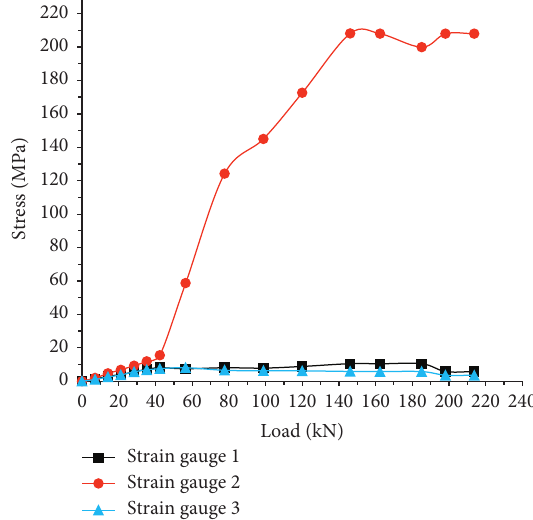
Figure 16: LPCSHTHSC SL-3 stress/load curves of tensile rein- forcement at different measuring